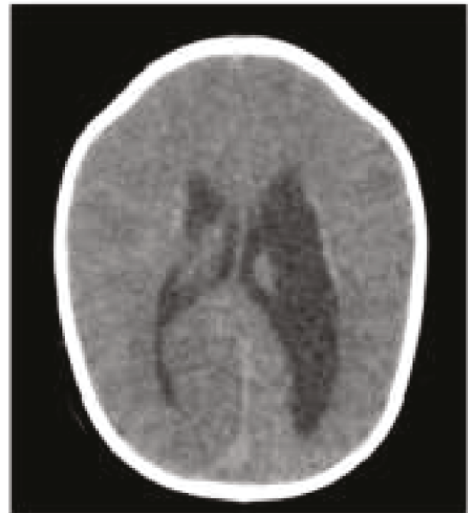
Figure 1: Brain CT, ventricular enlargement, and periventricular